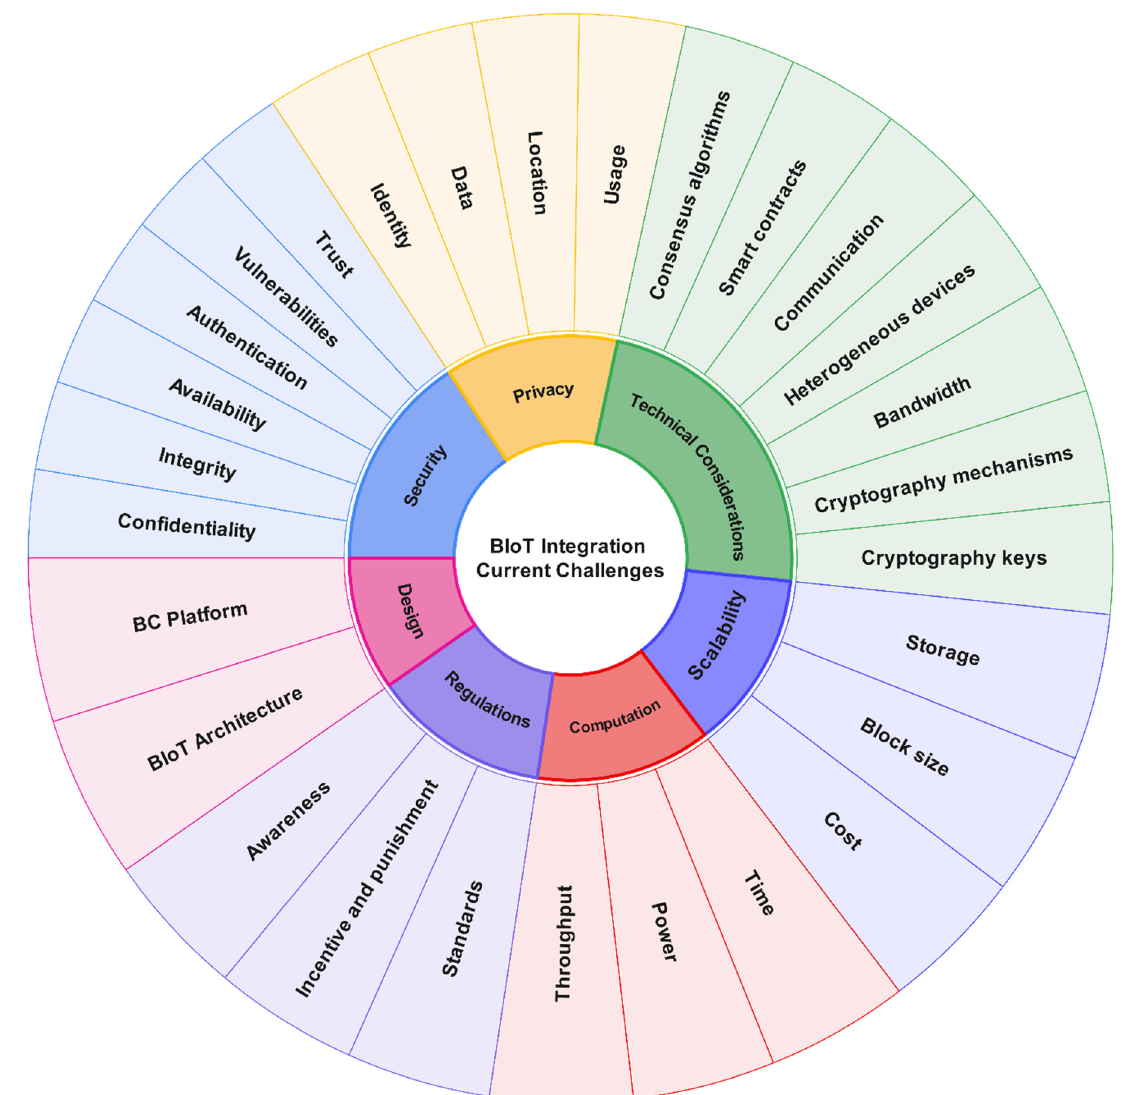
Figure 2. BIoT integration current challenges.